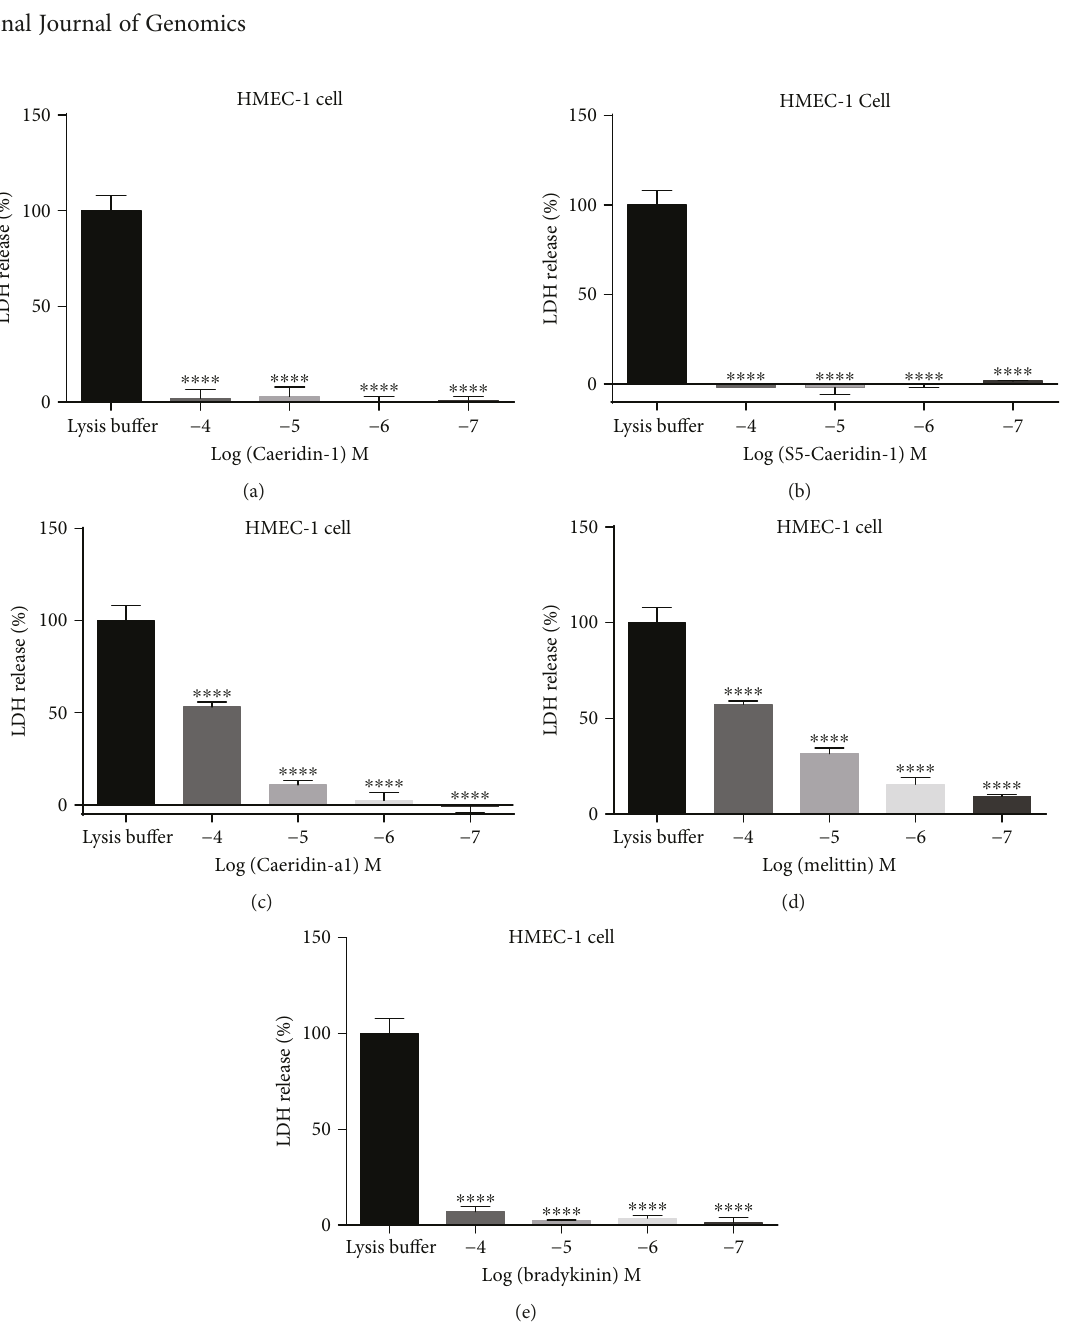
Figure 10: Membrane permeabilisation of human microvascular endothelial cell line, HMEC-1, re fl ected by the level of LDH released into the medium, after being treated by (a) Caeridin-1, (b) S5-Caeridin-1, (c) Caeridin-a1, (d) positive peptide melittin, and (e) negative peptide Bradykinin. The level of LDH release was calculated in comparison with the maximum LDH release control group (lysis bu ff er-treated)). ∗∗∗∗ p < 0 0001 represents a signi fi cant change in the level of LDH release, compared with the maximum LDH release control group (lysis bu ff er-treated), using one-way analysis of variance followed by Dunnett ’ s multiple comparisons tests. The error bar represents SEM of three independent experiment determinations and each experiment with